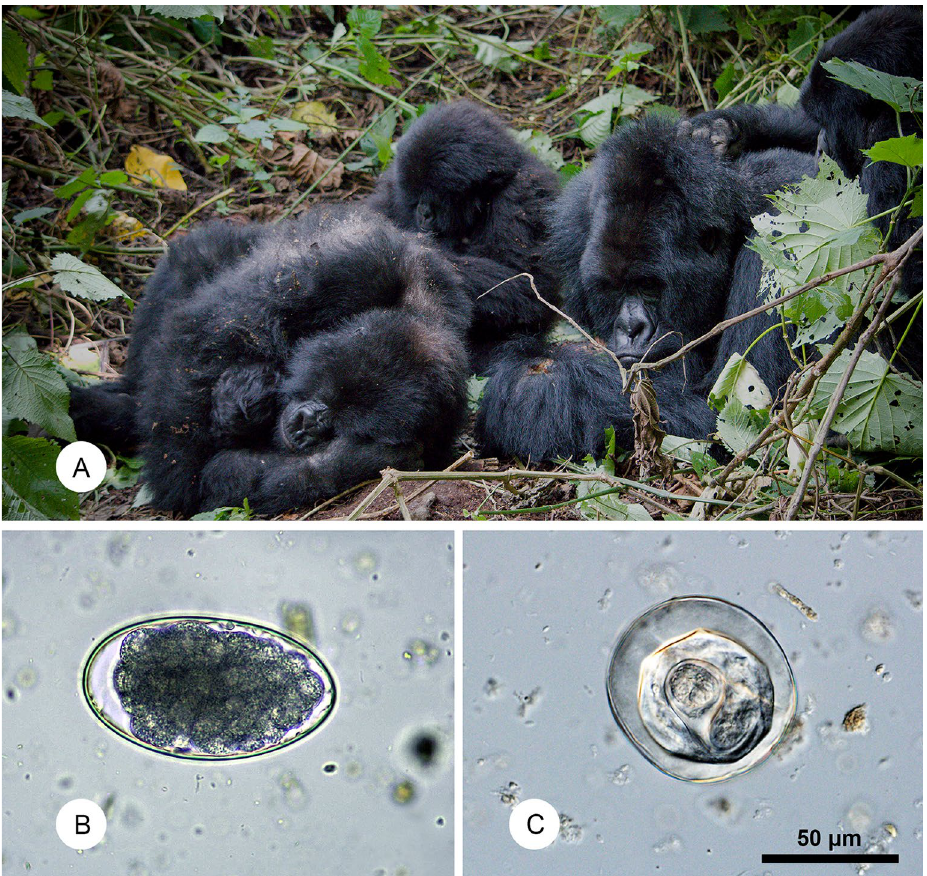
Figure 2. Examined host and their parasites quantified in the study: ( A ) resting group of mountain gorillas in Virunga Massif (Virunga National Park, Democratic Republic of the Congo); ( B ) egg of strongylid nematode; ( C ) egg of anoplocephalid tapeworm; both microphotographs in the same scale.